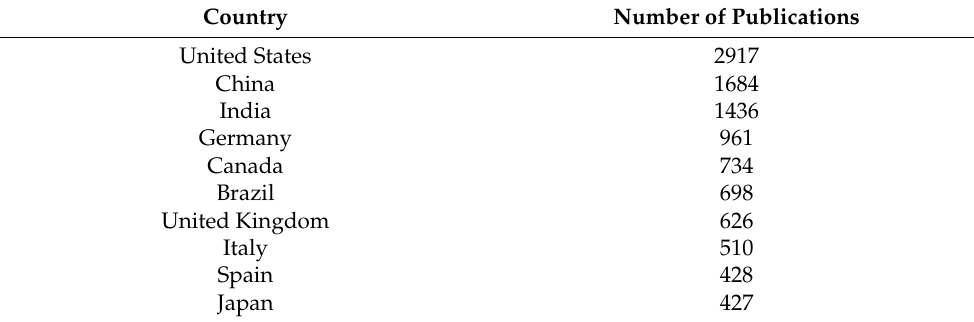
Table 1. Most productive countries.